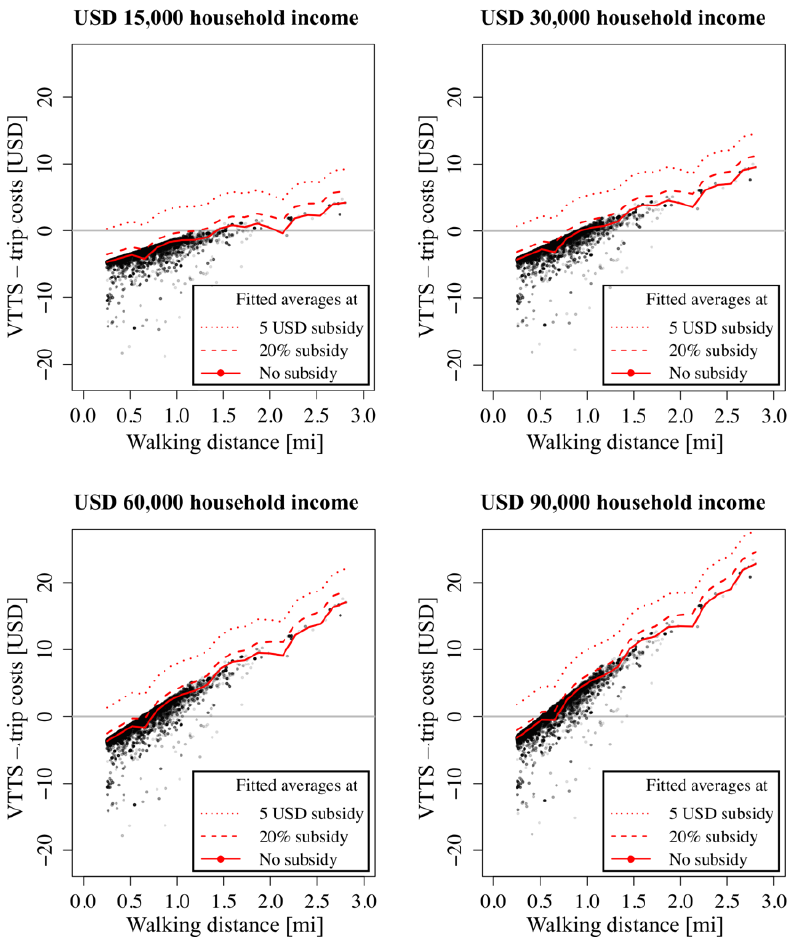
Figure 6. VTTS - Lyft price at four household incomes for first/last mile rides in Seattle with fitted averages (red lines) for different subsidy